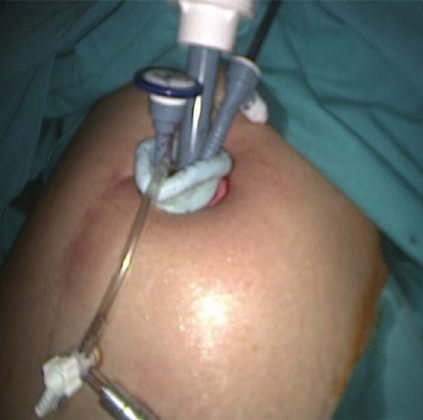
Figure 1: Appearance of SILS port and trocars at the beginning of the operation.